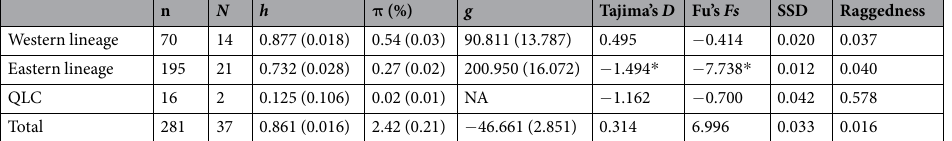
Table 2. Genetic diversity and demographic statistics for mitochondrial cytb haplotypes of B . tibetanus in the Qinling Mountains ( * P < 0.05; ** P < 0.01). Standard deviation of h , π and g estimates are shown in parentheses. n, the number of individuals; N , the number of haplotypes; h , haplotype diversity; π , nucleotide diversity;